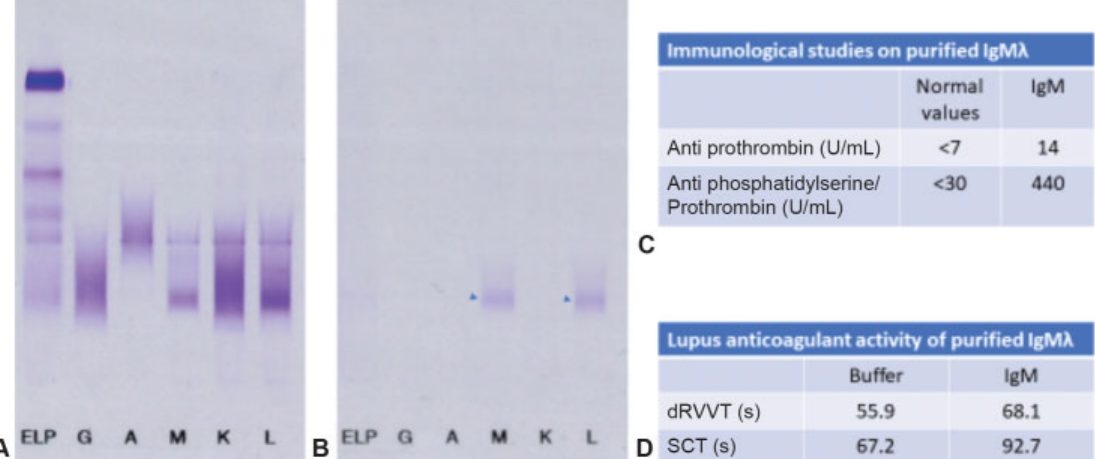
Fig. 1 Immuno fi xation of patient ’ s plasma showing a monoclonal immunoglobulin M lambda (IgM λ ) ( A ) and its immunoaf fi nity puri fi cation using a prothrombin af fi nity column ( B , arrowheads). Puri fi ed material yielded a marked positivity in anti-phosphatidylserine/prothrombin enzyme-linked immunosorbent assay ( C ) and possessed lupus anticoagulant activity as shown by diluted Russell viper venom time (dRVVT) and silica clotting time (SCT) ( D